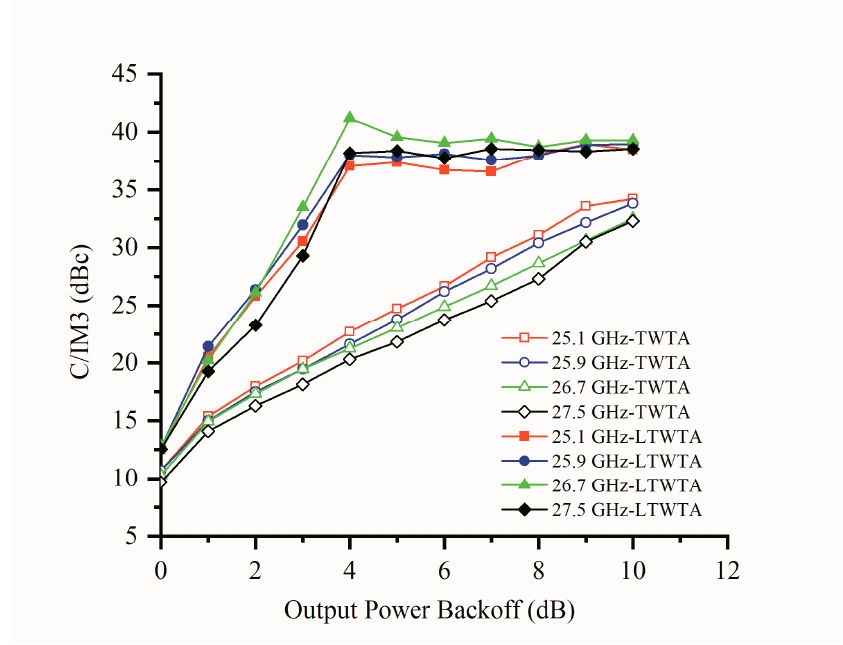
Figure 12. The C/IM3 performance before and after the proposed APD MMIC circuit.